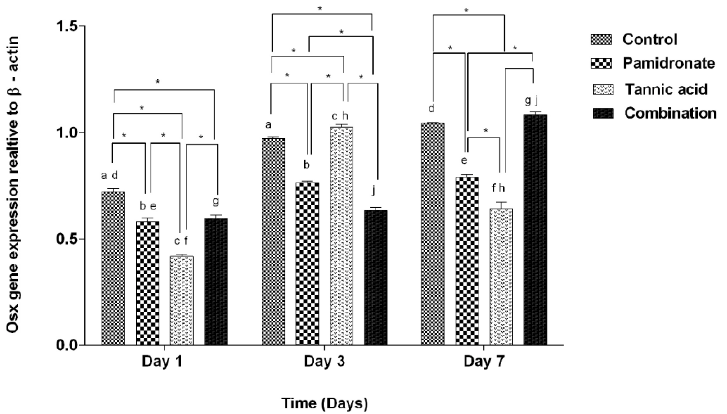
Figure 6. The gene expression of Osx relative to β -actin at Days 1, 3, and 7 in hFOB 1.19 cells ex- pressed by control (DMSO treated), pamidronate (PAM), tannic acid (TA), and combination treatment (TA + PAM) groups, analyzed by PCR. All data are shown as the mean (SEM) of three independent experiments. Days that share the similar letter display a significant difference within the same group ( p < 0.05), whereas * shows significant difference among the four groups in similar days ( p < 0.05) by one-way ANOVA and Tukey’s test.